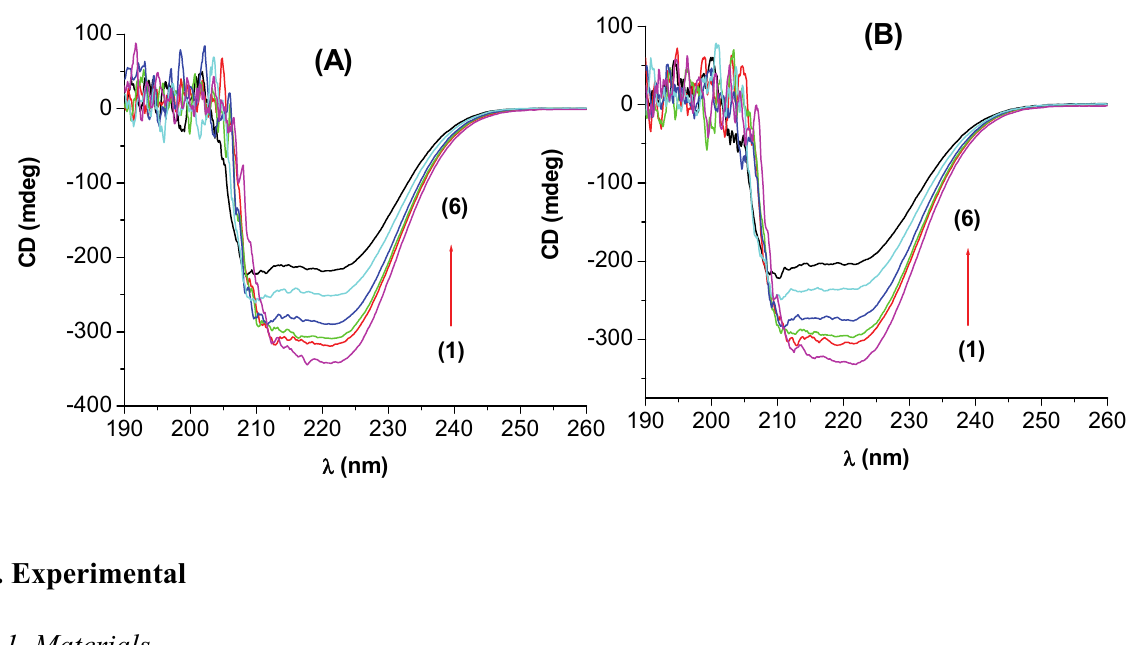
Figure 9. CD spectra of the (A) HSA– I system; (B) BSA- I system at pH 7.4;